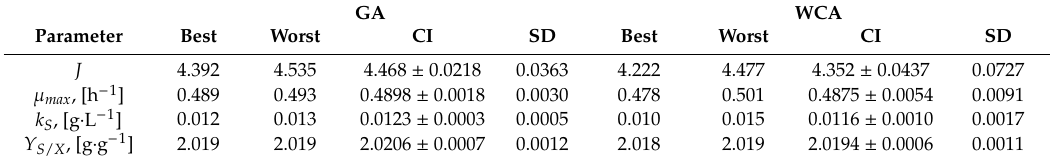
Table 2. Case study 1 : Comparison of the results obtained by GA and WCA. CI: Confidence